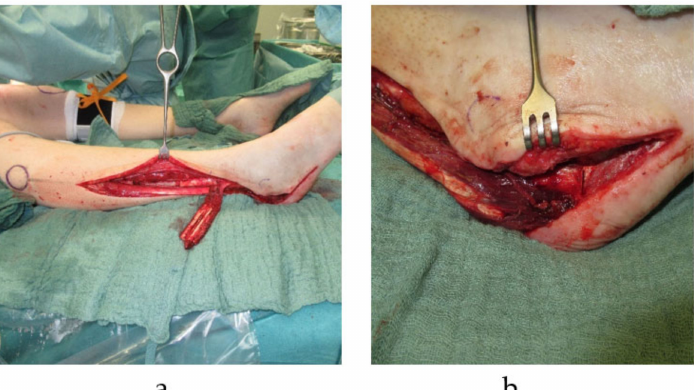
Figure 1. Pedicled autologous bone graft transplantation. Distally pedicled peroneus brevis muscle flap with a fibula segment is harvested from the right lower leg. The transplant is used for recon- struction of a calcaneus defects with a soft tissue defect ( a ). Distally pedicled peroneus brevis muscle flap is transferred into right calcaneal bone defect ( b ).